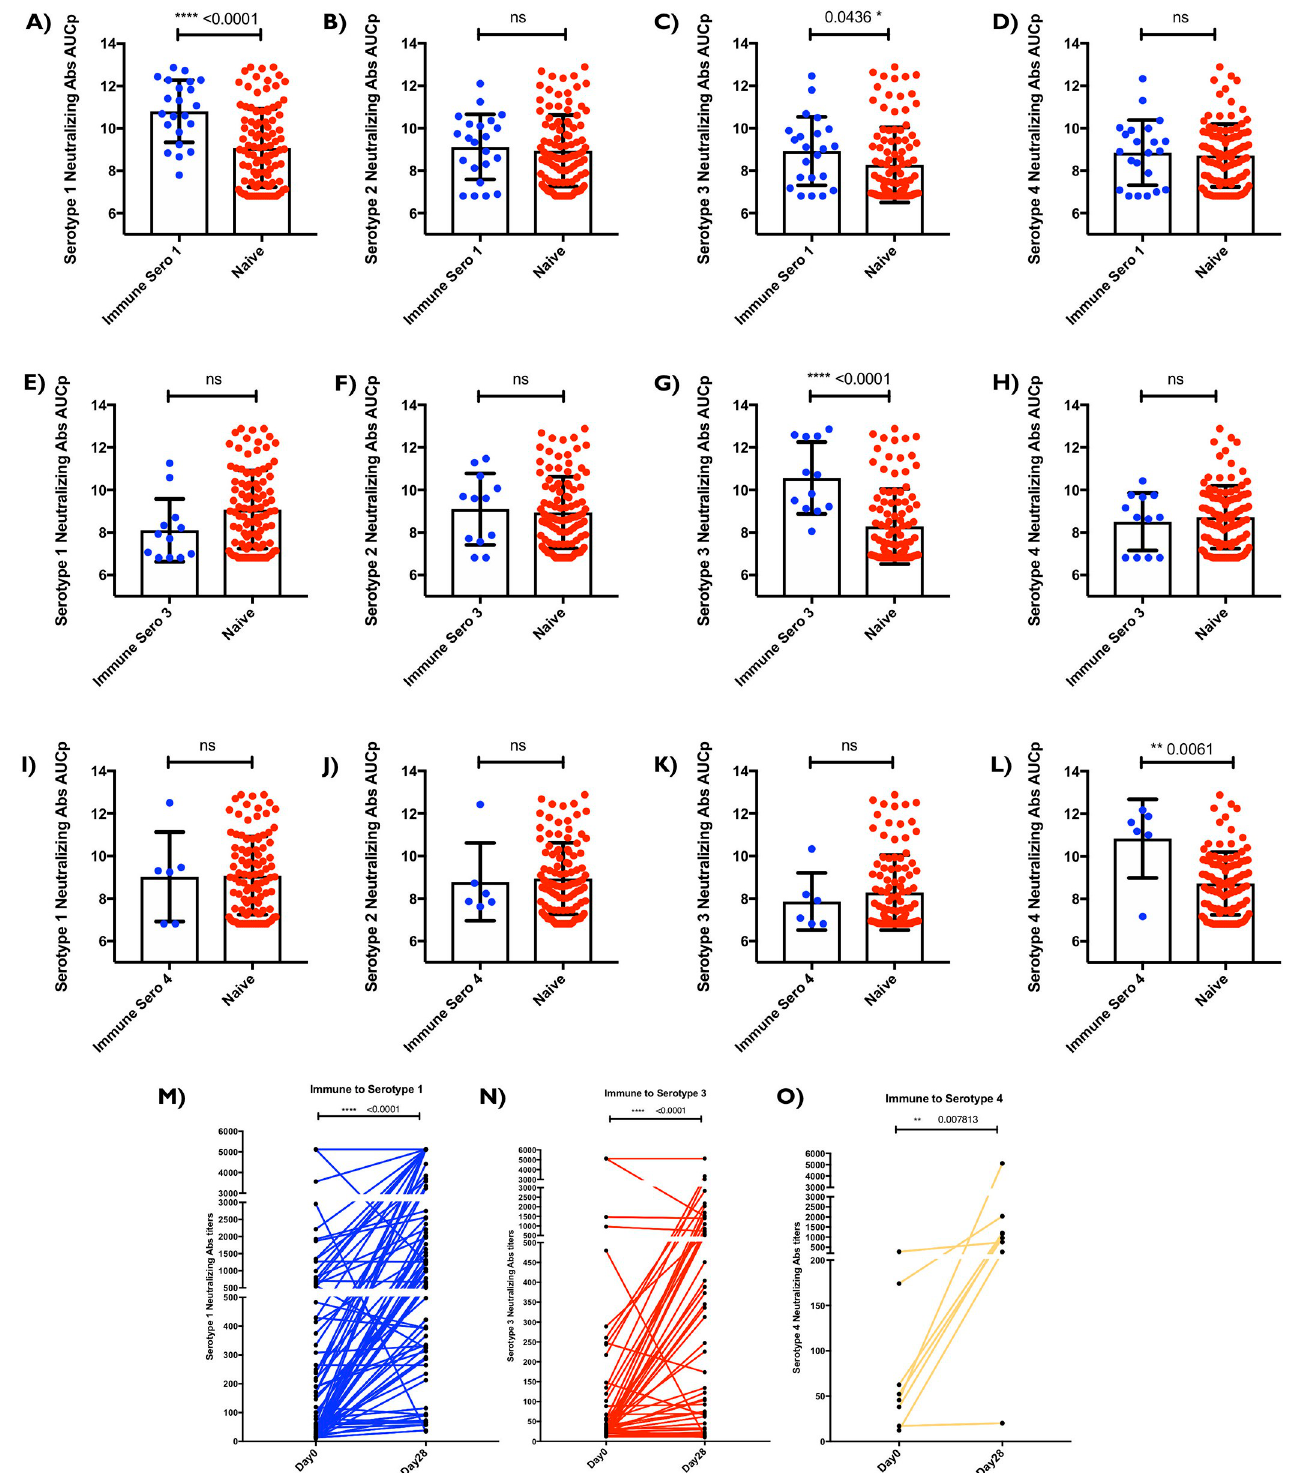
Fig 2. TV003 vaccine induced neutralizing antibody titers AUCp is dependent on pre-vaccination serotype. (A, B, C &D) “Immune Sero 1” are subjects who only had Dengue Serotype I neutralizing antibody titers (AUCp) at pre-vaccination/baseline time point. (E, F, G &H) “Immune Sero 3” are subjects who only had Dengue Serotype 3 neutralizing antibody titers (AUCp) at pre-vaccination/baseline time point. (I, J, K &L) “Immune Sero 4” are subjects who only had Dengue Serotype 4 neutralizing antibody titers (AUCp) at pre-vaccination/baseline time point. Seronegative subjects with no existing antibodies to any of